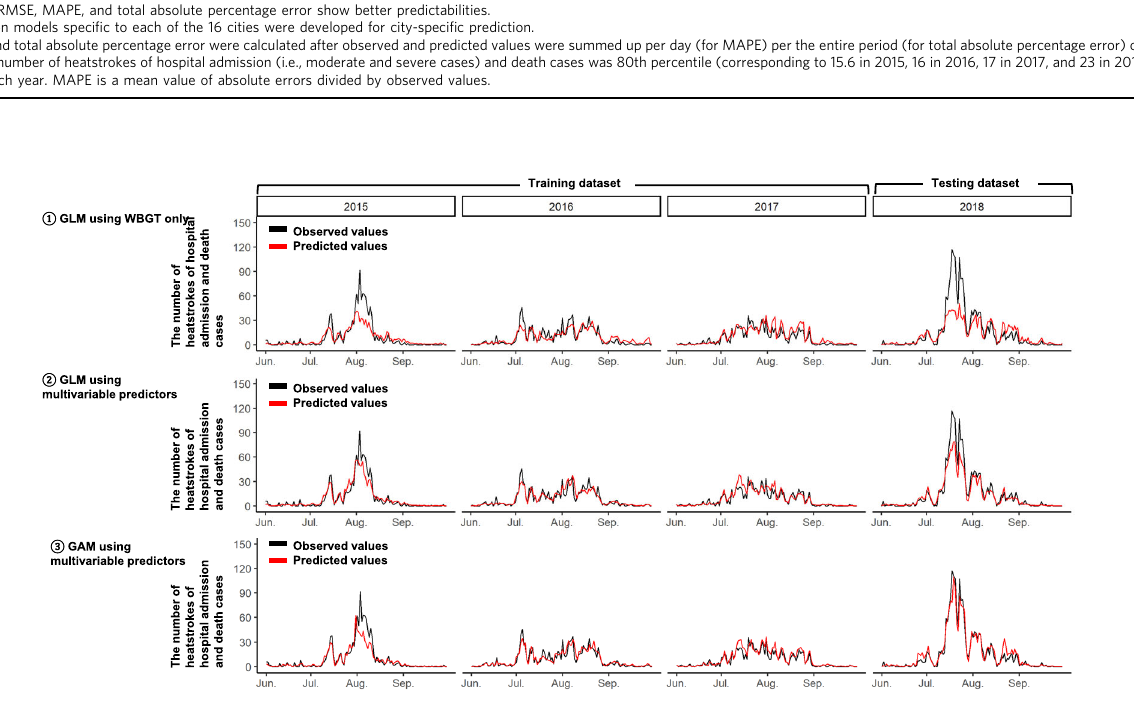
Fig. 4 Comparison between observed and predicted numbers of heatstrokes of hospital admission and death cases from June to September in 2015, 2016, and 2017 (i.e., training dataset), and 2018 (i.e., testing dataset) by GLMs and GAM. The black lines indicate the observed total number of heatstroke per day in the 16 Japanese cities, and the red lines indicate the predicted total number of heatstroke per day in the 16 Japanese cities obtained from the following prediction models: (1) GLM using WBGT as the only predictor, (2) GLM using multivariable predictors, and (3) GAM using multivariable predictors. GLM generalized linear model, GAM generalized additive model, WBGT wet bulb globe